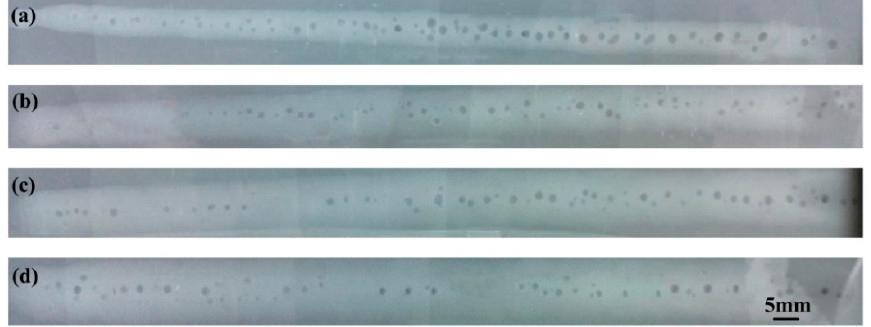
Figure 7. X-ray NDT photos of welds for different welding currents: ( a ) I = 100 A, ( b ) I = 140 A, ( c ) I = 160 A, and ( d ) I = 200 A.